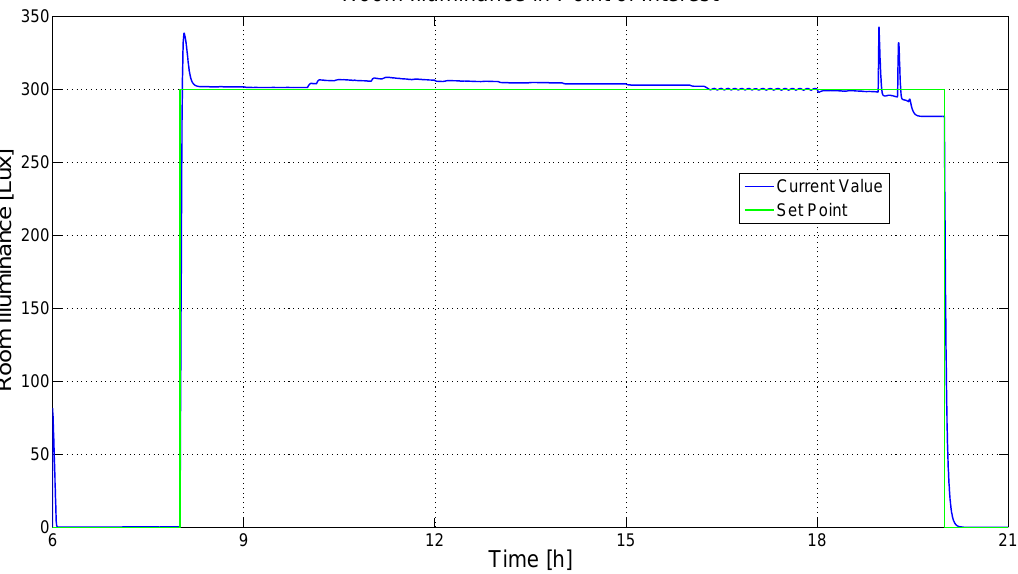
Figure 37. Control results (third scenario, modified control system, Comfort policy): room illuminance (CV).